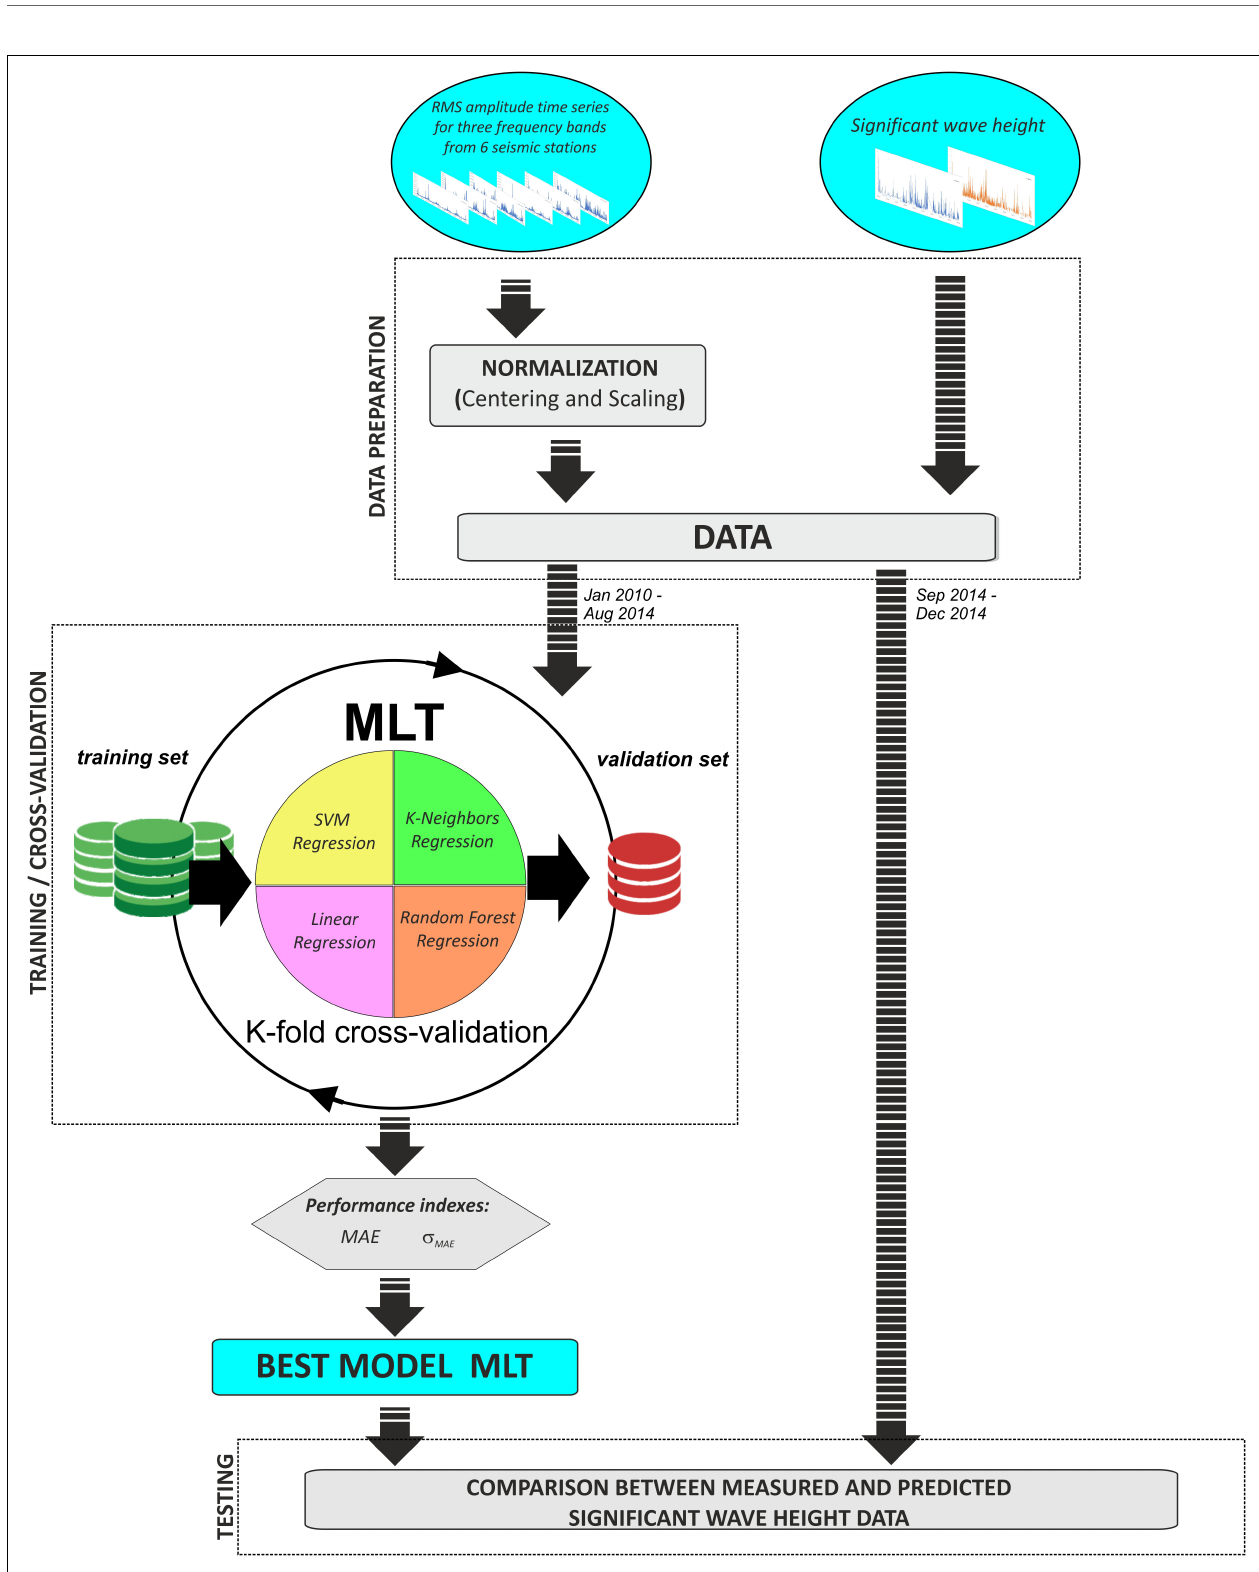
FIGURE 9 | Scheme of the modeling analysis to obtain the time series of significant wave height in the Catania and Cetraro buoy locations by using the microseism (see text for details). MLT , machine learning technique; MAE , mean absolute error; “ σ MAE ”, standard deviation computed on the mean absolute error; SVM support vector